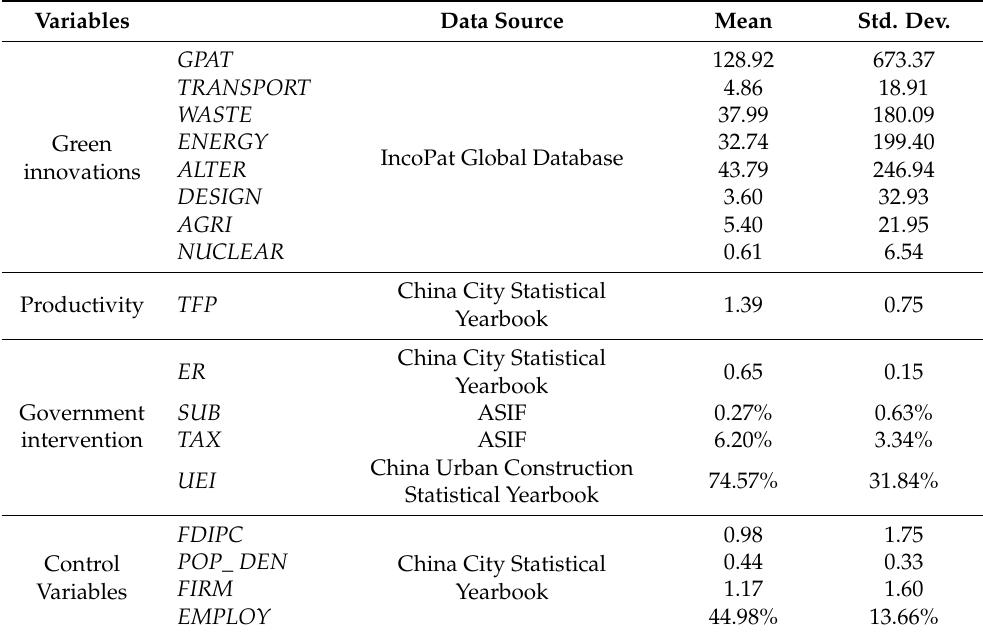
Table 1. Descriptive Statistics of Model